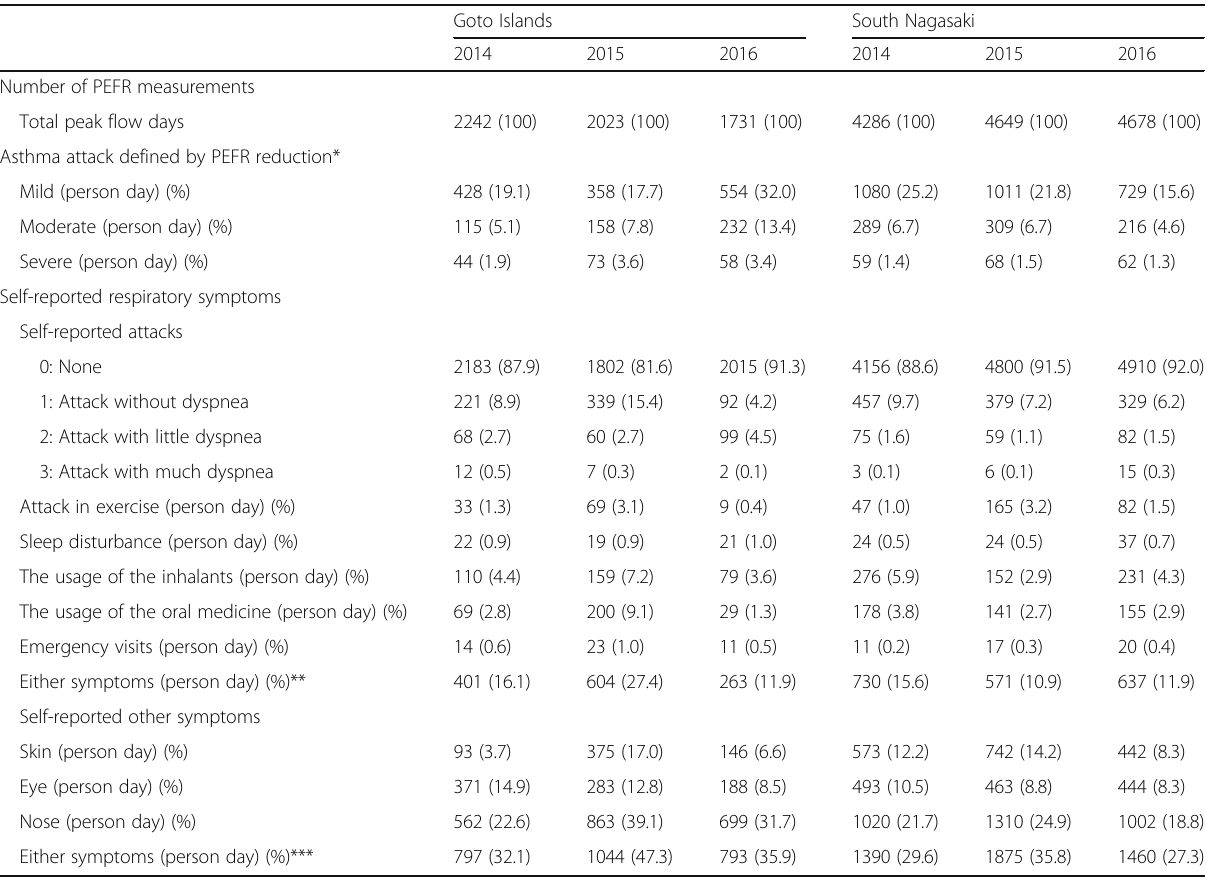
Table 3 Incidence of asthma attacks and clinical symptoms Goto Islands South